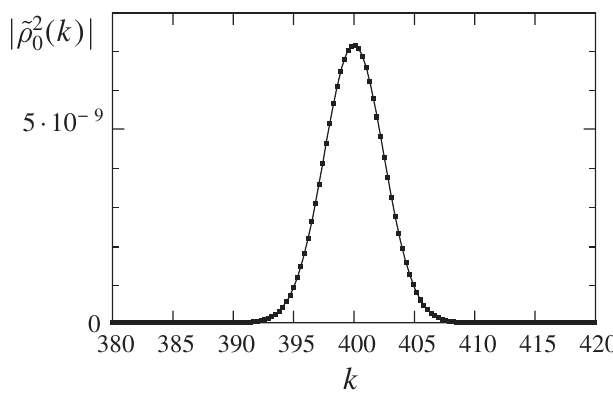
¼ 400 , (cid:9) ¼ 0 : 3 , m L